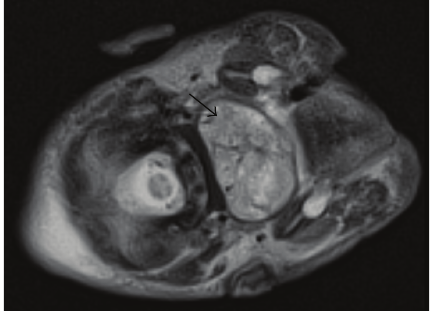
Figure 2: T2 weighted MRI of NPT (axial